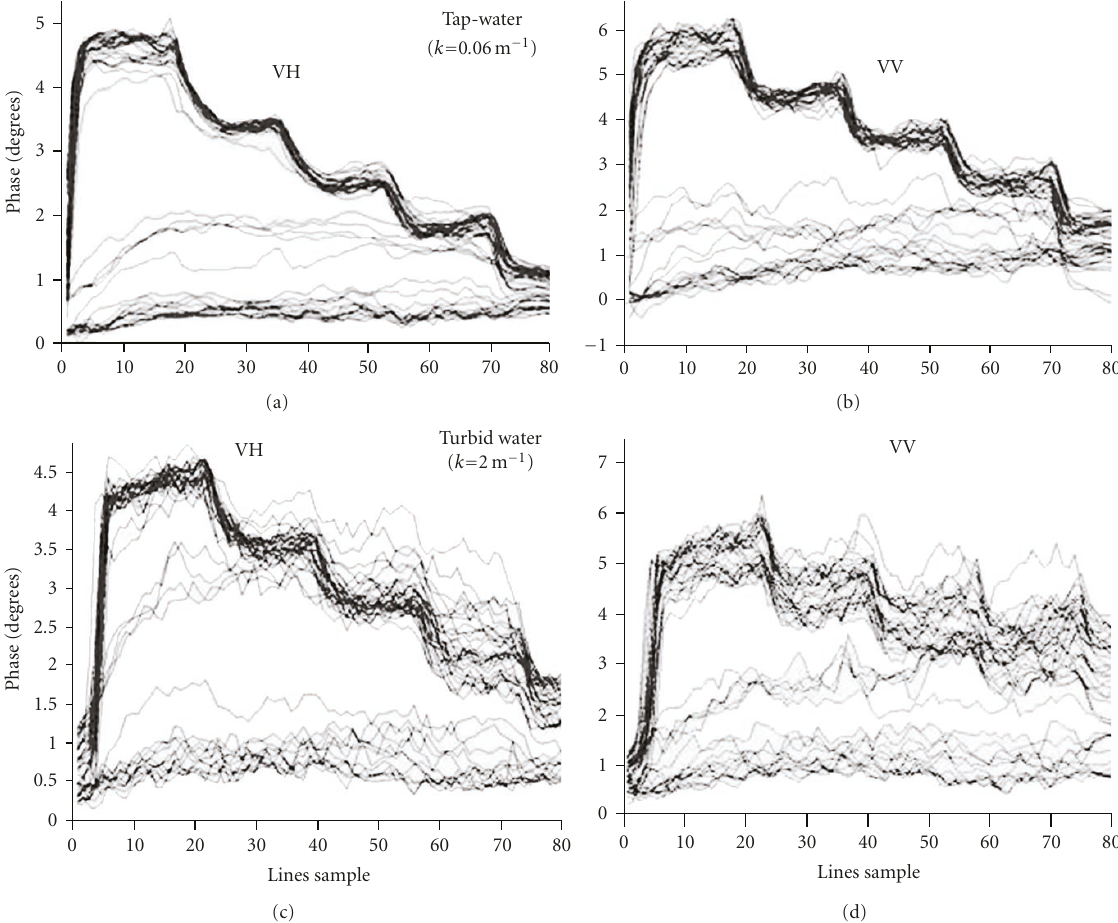
Figure 13: Linear phase profiles of a small metallic ladder, obtained by using cross-polarized (VH) and copolarized (VV) working schemes. The ladder was alternatively immersed in clean (tap water) and turbid water at 1.5m from the receiver.